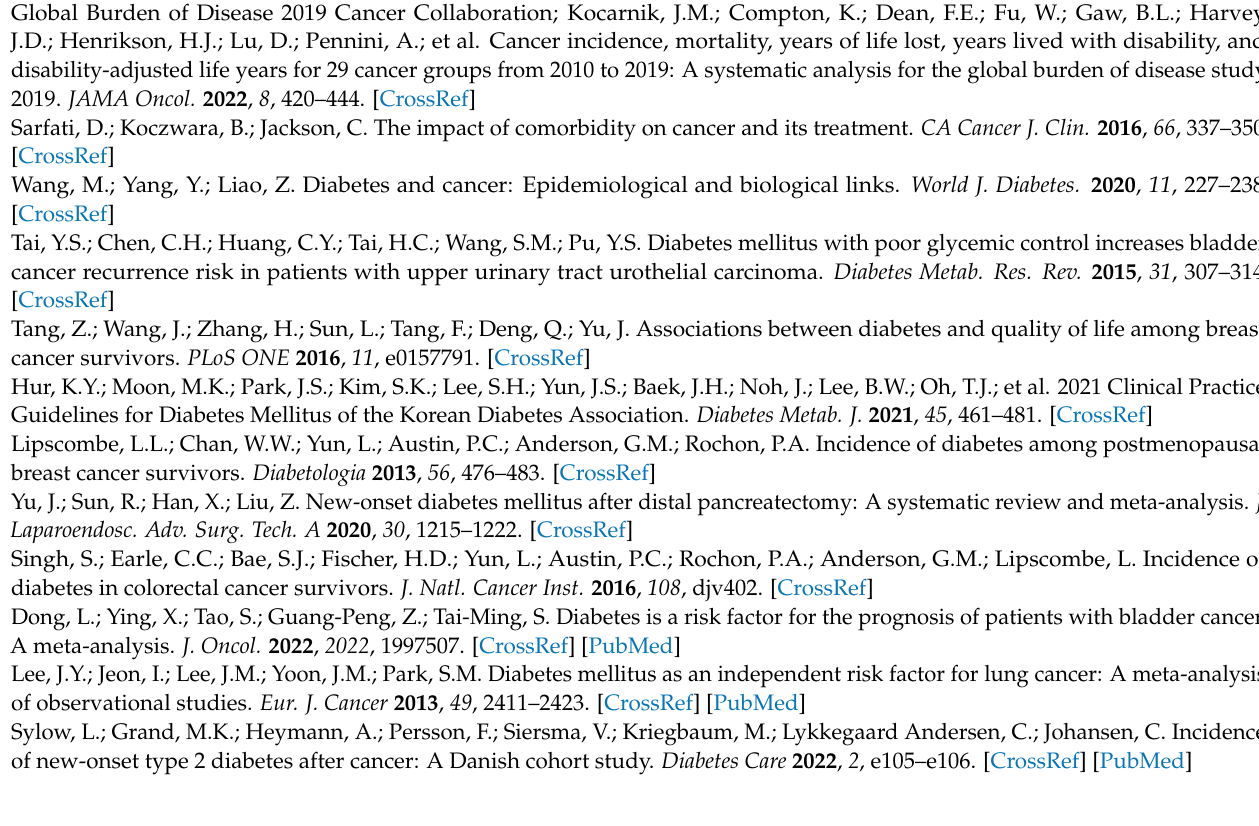
Table S3: Baseline characteristics of the study population according to the independent variables; Table S4: Hazard ratios of incident diabetes by sex and age between comparison and cancer groups; Table S5: Subgroup analysis for incidence and risk of specific diabetes-associated complications in cancer